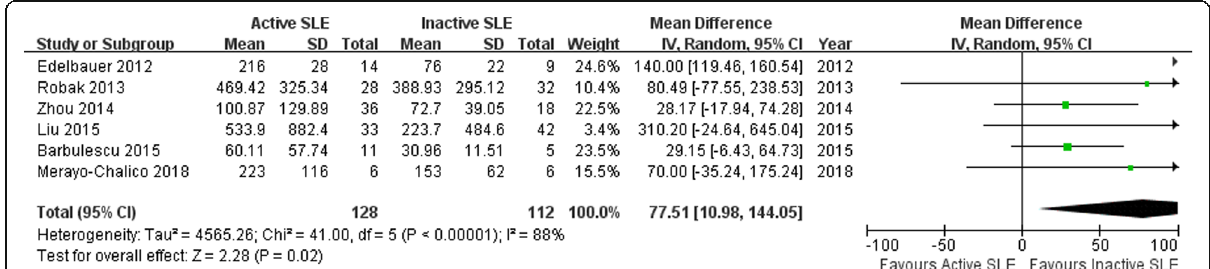
Fig. 2 Association of vascular endothelial growth factor protein levels with active SLE risk. SLE: systemic lupus erythematosus; SD: standard deviation; Total: the total number of SLE group or control group; CI: confidence intervals; I 2 : test the heterogeneity among recruited studies; df: